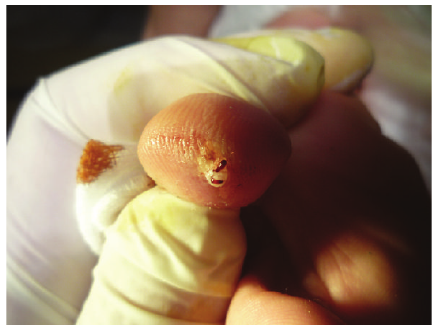
Figure 3: Excision of the lesions.